Question: Produce a descriptive caption suitable for publication.
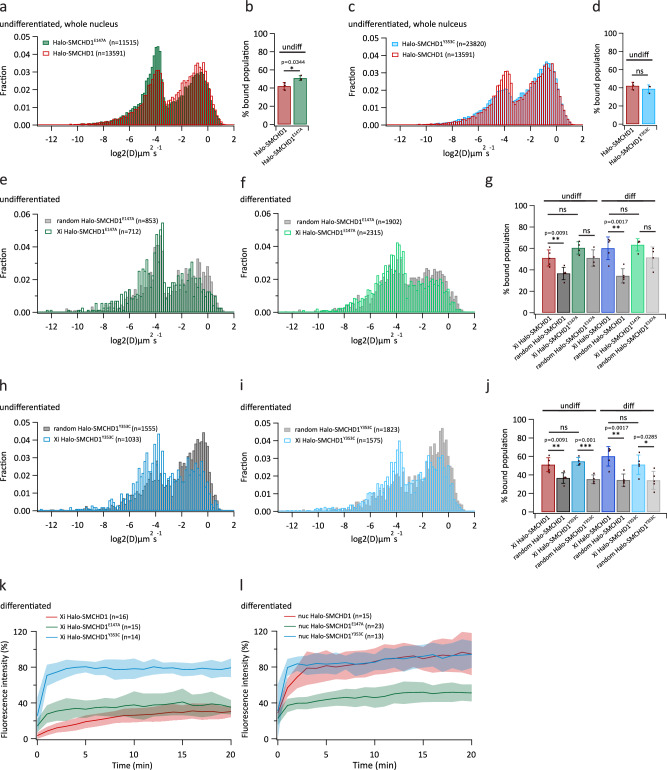
Answer: SMCHD1 GHKL ATPase loss-of-function mutations alter chromatin binding behaviour. a In red, same as Fig. 2d . In green, normalised histogram of diffusion coefficients of tracks from across the whole nucleus in undifferentiated Halo-SMCHD1 E147A mESCs, kept for 24 h with doxycycline. b Bar plots showing the average percentage of bound molecules of SMCHD1 (3 independent replicates each). Error bars represent the STDEV (two-sided unpaired t-test). c In red, same as Fig. 2d . In turquoise, normalised histogram of diffusion coefficients of tracks from across the whole nucleus in undifferentiated Halo-SMCHD1 Y353C mESCs, kept for 24 h with doxycycline. d Bar plots showing the average percentage of bound molecules of SMCHD1 (3 independent replicates each). Error bars represent the STDEV (two-sided unpaired t-test). e Normalised histogram of diffusion coefficients of tracks from Xi (dark green) or a random region (dark grey) in undifferentiated Halo-SMCHD1 E147A mESCs, kept for 24 h with doxycycline. f Normalised histogram of diffusion coefficients of analysed tracks from Xi (light green) or a random region (light grey) in Halo-SMCHD1 E147A mESC differentiated for 7 days. g Bar plot showing the average percentage of bound molecules of SMCHD1 (5 or 4 independent replicates for Halo-SMCHD1 and Halo-SMCHD1 E147A , respectively) mESCs. Error bars represent the STDEV (two-sided unpaired t-test). h Normalised histogram of diffusion coefficients of tracks from the Xi (turquoise) or a random region (dark grey) in undifferentiated Halo-SMCHD1 Y353C mESCs, kept for 24 h with doxycycline. i Normalised histogram of diffusion coefficients of tracks from Xi (light blue) or a random region (light grey) in Halo-SMCHD1 Y353C mESCs differentiated for 7 days. j Bar plot showing the average percentage of bound molecules of SMCHD1 (5 independent replicates each). Error bars represent the STDEV (two-sided unpaired t-test). k , l Average fluorescence recovery curves over the Xi domain ( k ) or a r